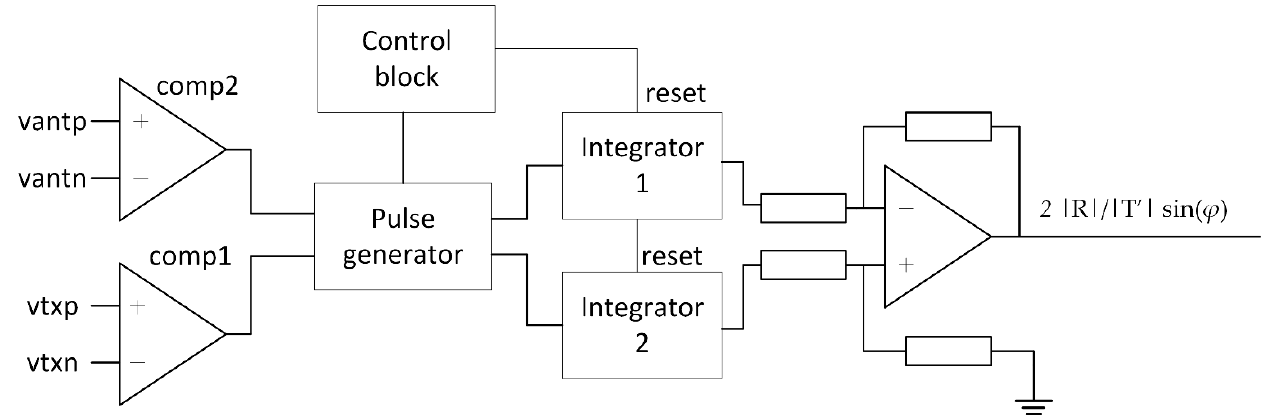
Figure 10. Circuit for phase difference measurement corresponding to equation (6).